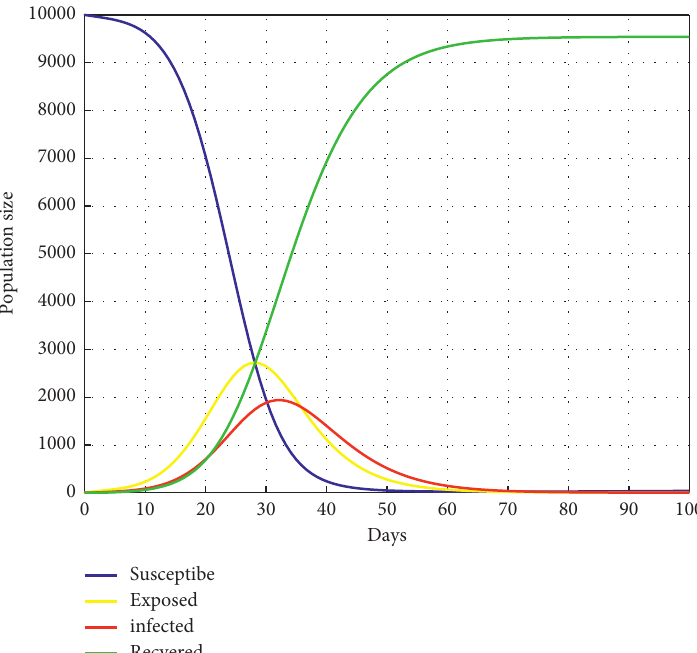
Figure 3: Evolution of the epidemic spreading considering the vector-to-human and the human-to-human transmission routes, i.e., vertical transmission rate π �